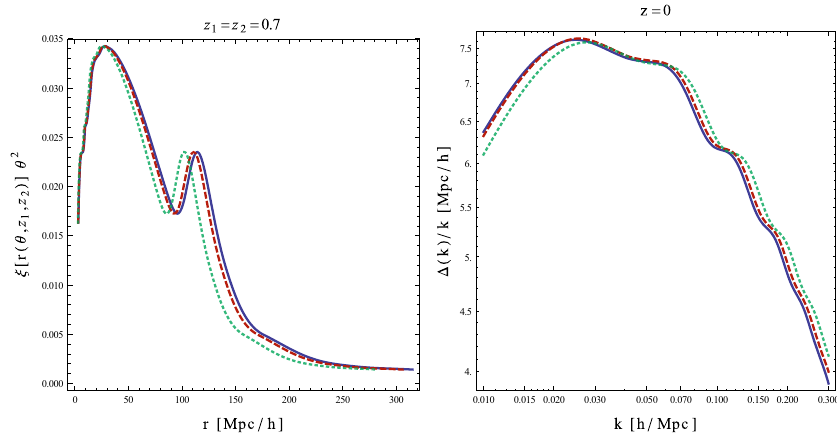
Fig.13 Effect of wrongcosmological parameters onthe power spectrum. The true one(solid line) assumes the cosmological parameters of Komatsu et al. (2011) (in particular Ω m = 0 . 27) and takes into account redshift space distortions. The wrong assumptions Ω m = 0 . 3 , 0 . 5 (dashed and dotted line, respectively) rescale the correlation function (on the left, multiplied by θ 2 to enhance the BAOs) and the dimensionless power spectrum (on the right, divided by k to enhance the